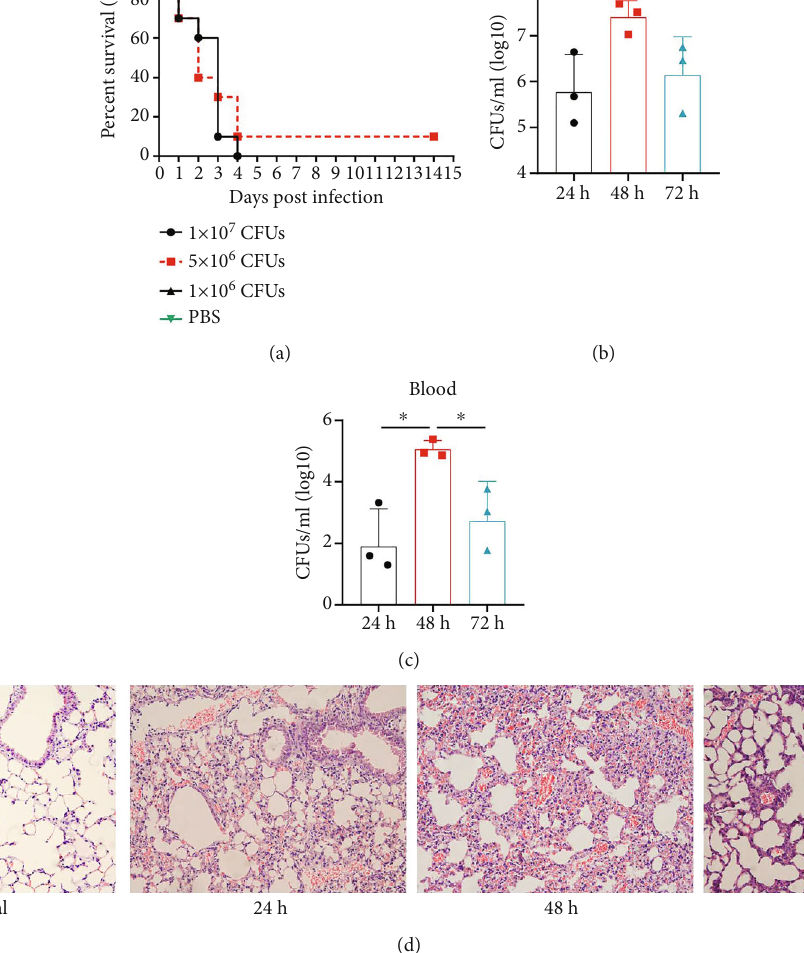
Figure 1: K. pneumoniae strain YBQ induced lethal pneumonia. (a) Group-randomized BALB/c mice ( n = 10 ) were intratracheally inoculated with 1 × 10 7 , 5 × 10 6 , and 1 × 10 6 CFU of K. pneumoniae YBQ, and survival was monitored for 14 days. Bacterial burden ( n = 3 ) of lungs (b) and blood (c) were detected 24, 48, and 72 hours post infection. (d) Histopathology analysis (200 × ) of lungs was captured 24, 48, and 72 hours post infection. Bacterial burdens were presented as means ± SEM